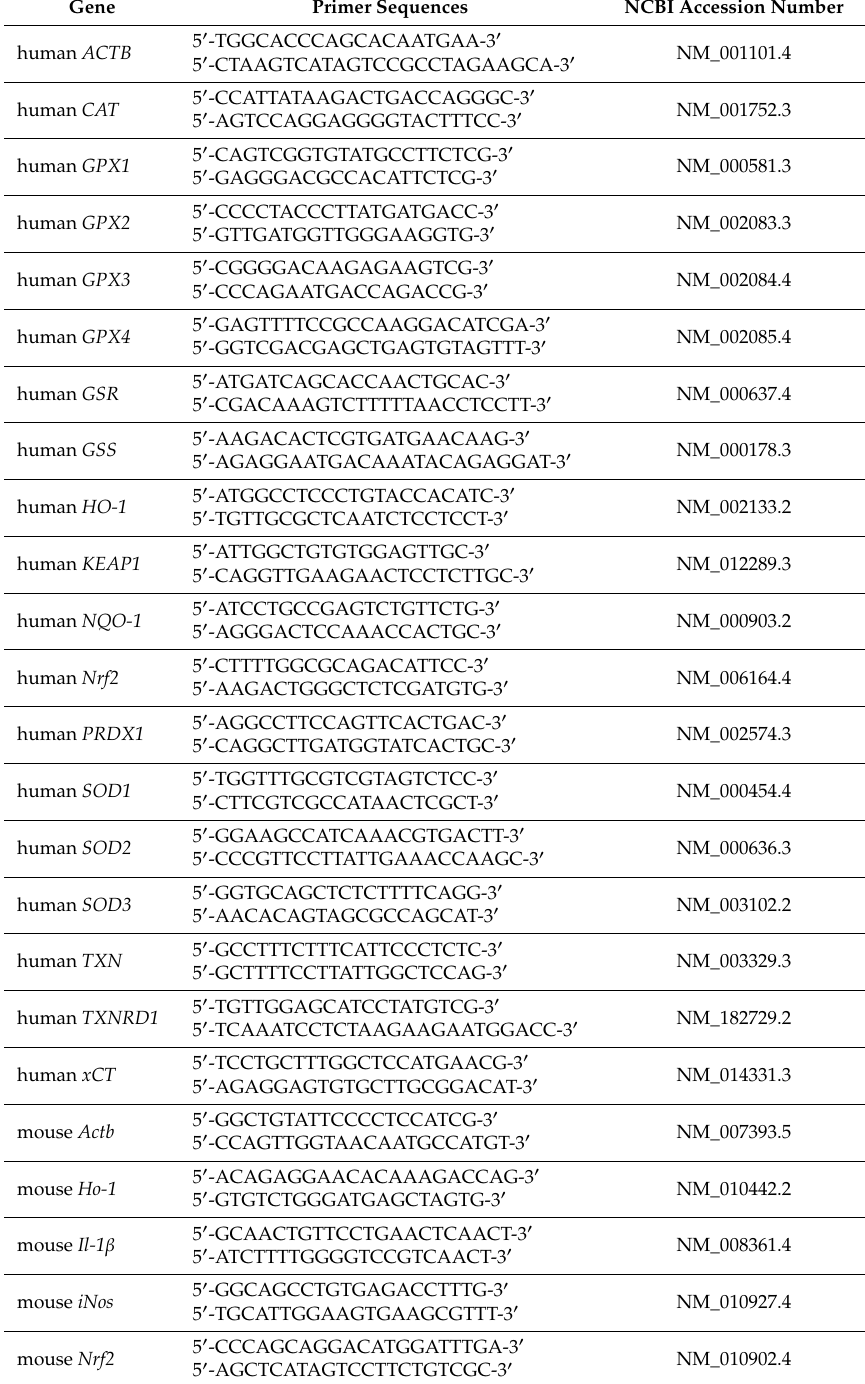
Table 1. Primer sets for